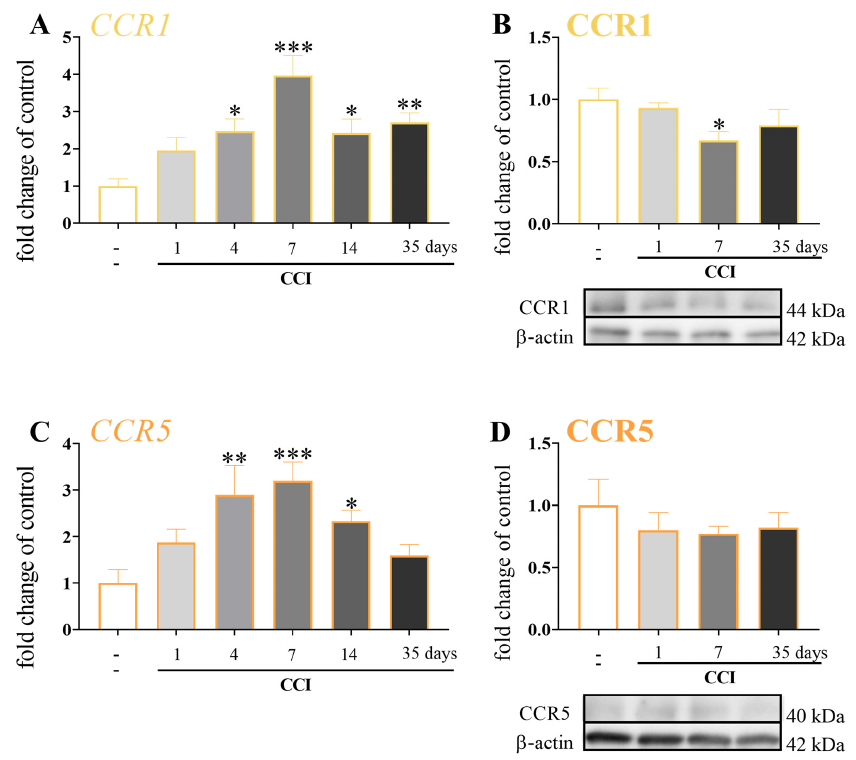
Figure 5 Figure 5. Time-dependent changes in the mRNA levels of CCR1 ( A ) and CCR5 ( C ) measured via RT-qPCR and changes in the protein levels of CCR1 ( B ) and CCR5 ( D ) measured using Western blot in the spinal cord of naive and chronic CCI-exposed mice (from 1 to 35 days). The data are presented as the mean fold changes relative to the control ± SEM (n = 4–9). The results were evaluated using one-way ANOVA followed by Bonferroni’s post hoc test for comparisons of selected pairs. * p < 0.05, ** p < 0.01, and *** p < 0.001 indicate significant differences vs. the naive group. Abbreviations: -: naive; CCI: chronic constriction injury of the sciatic